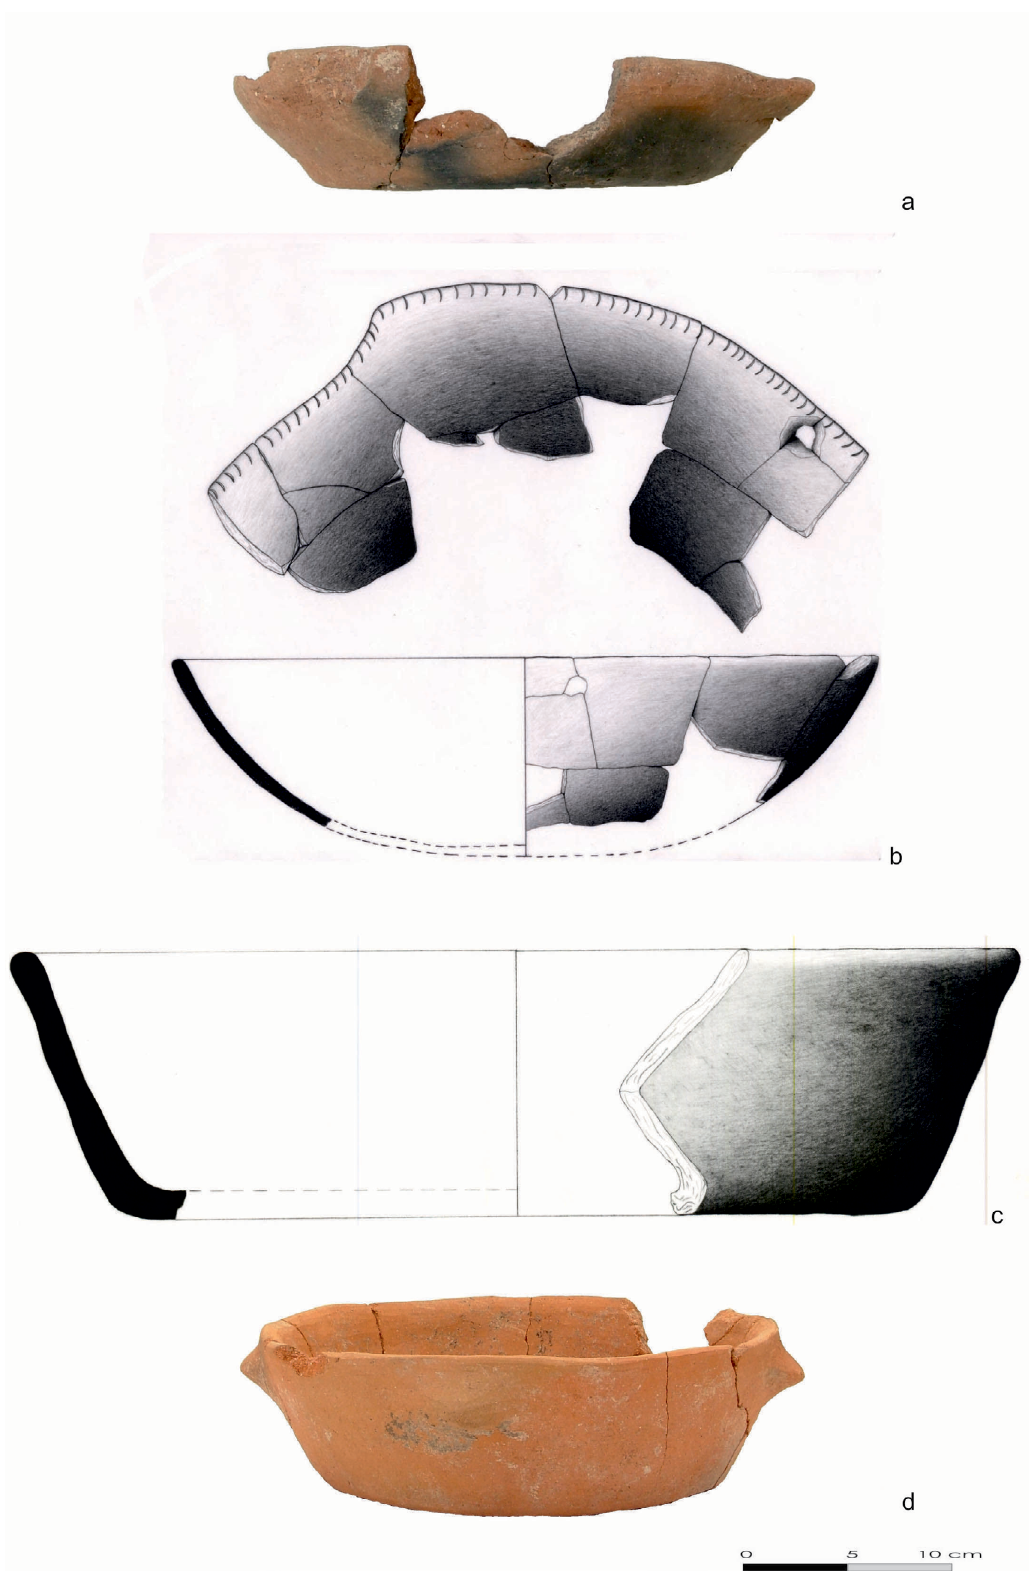
Figure 10. Shallow open-shaped pots of small size from Stavroupoli. (Lekanes. Urem-Kotsou, Gioura